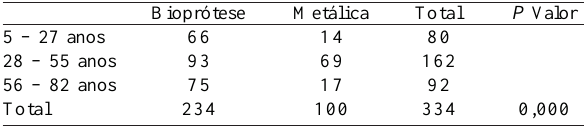
Tabela 2. Idade x tipo de